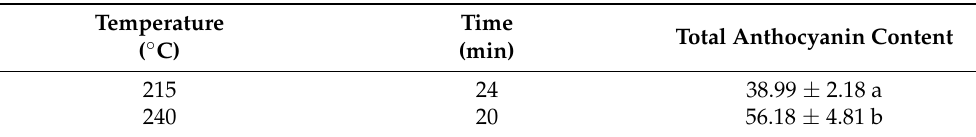
Table 9. Total anthocyanin content (mg anthocyanin/kg wholemeal) of bread made from An- thoGrain™ wholemeal baked at 215 ◦ C and 240 ◦